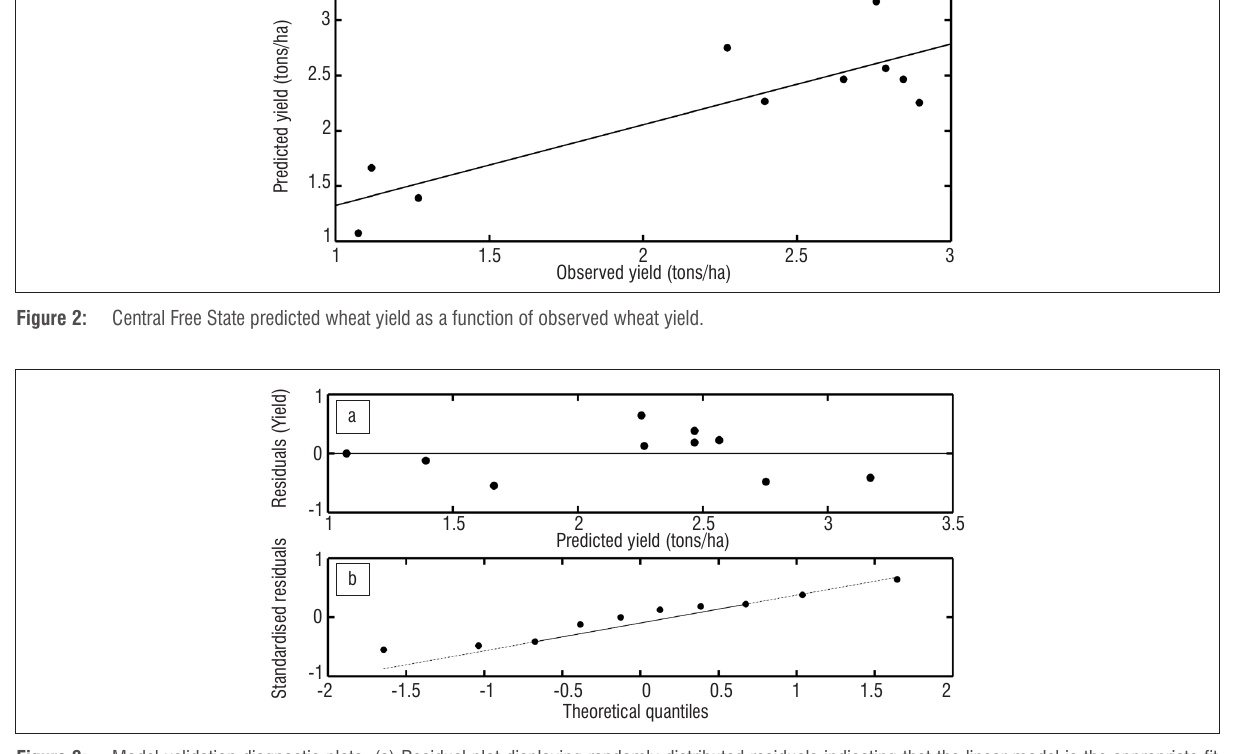
Table 1: Model testing results for the observed and predicted yield Observed yield (O) Year (tons/ha)